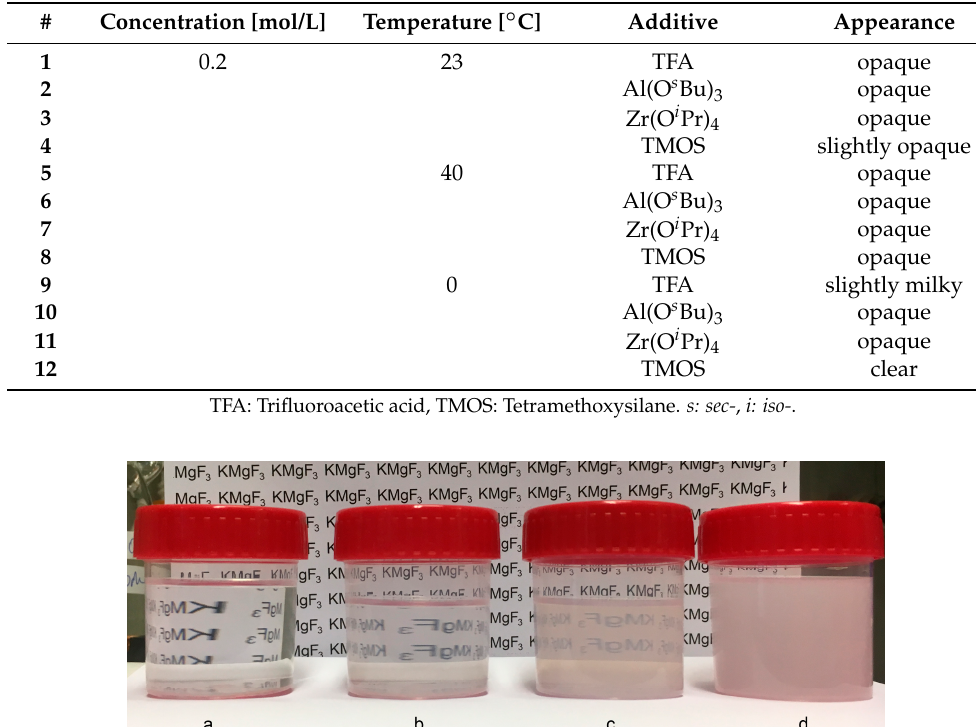
Table 3. Parameters of KMgF 3 syntheses.